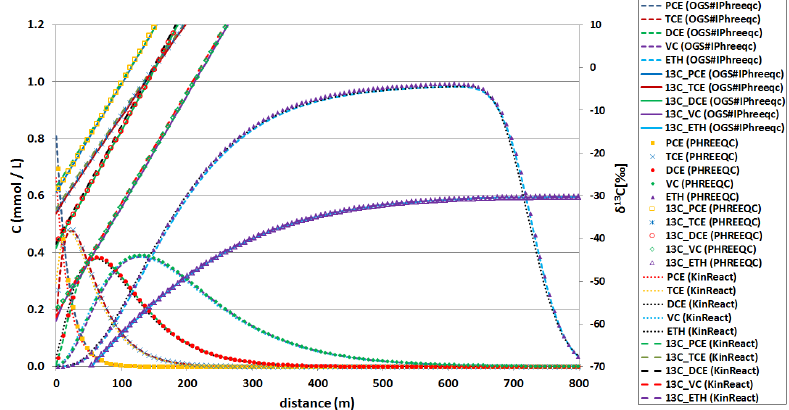
Figure 4. Concentration profiles of the light CHC isotopologues and δ 13 C [‰] isotope signatures along the horizontal axis of the model domain simulated by OGS#IPhreeqc (dashed lines or full lines) and PHREEQC (symbols) at the end of the simulations after 20 years. Table 4. An overview of different portions of the simulation time for the Engesgaard benchmark by using different codes (in seconds).